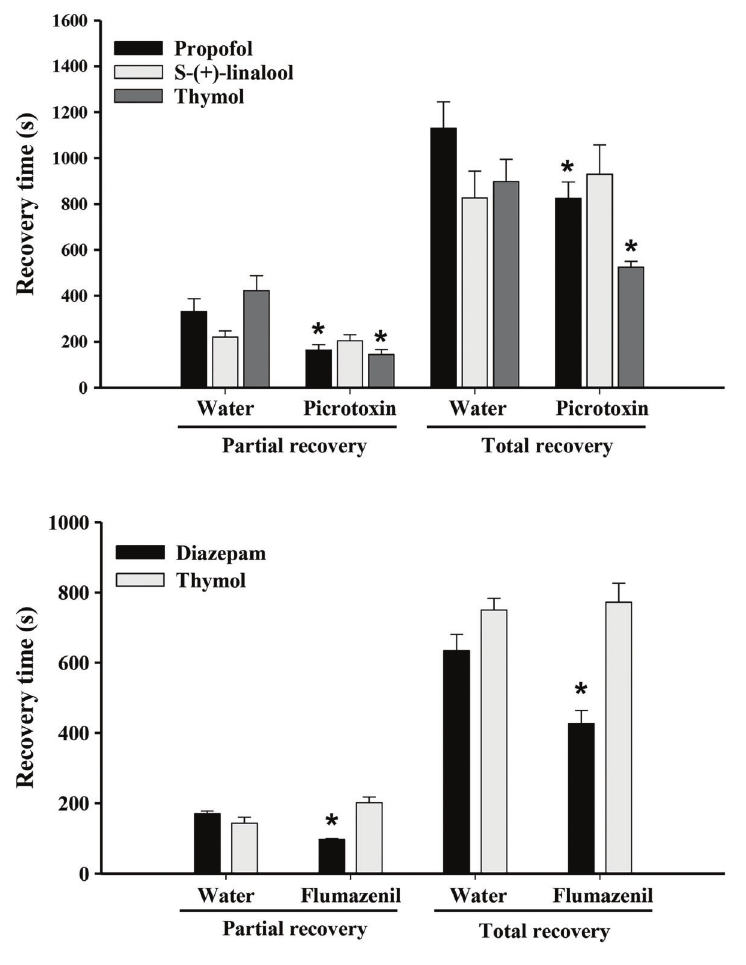
Figure 3. Time required for recovery (partial and total) in water and picrotoxin (100 mg/L) of silver cat fi sh ( Rhamdia quelen ) juveniles anesthetized with propofol (2.5 mg/L), S-( + )-linalool (153 mg/L) and thymol (50 mg/L). Data are reported as means ± SD (n=8). *P o 0.05, compared to the group that recovered in water (two-way ANOVA and Tukey ’ s